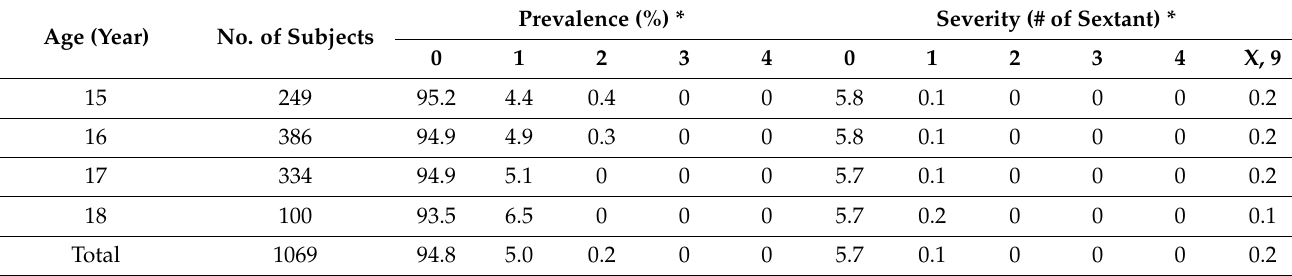
Table 2. The prevalence and severity of LA † among Taiwanese students aged 15–18 years. Age (Year)